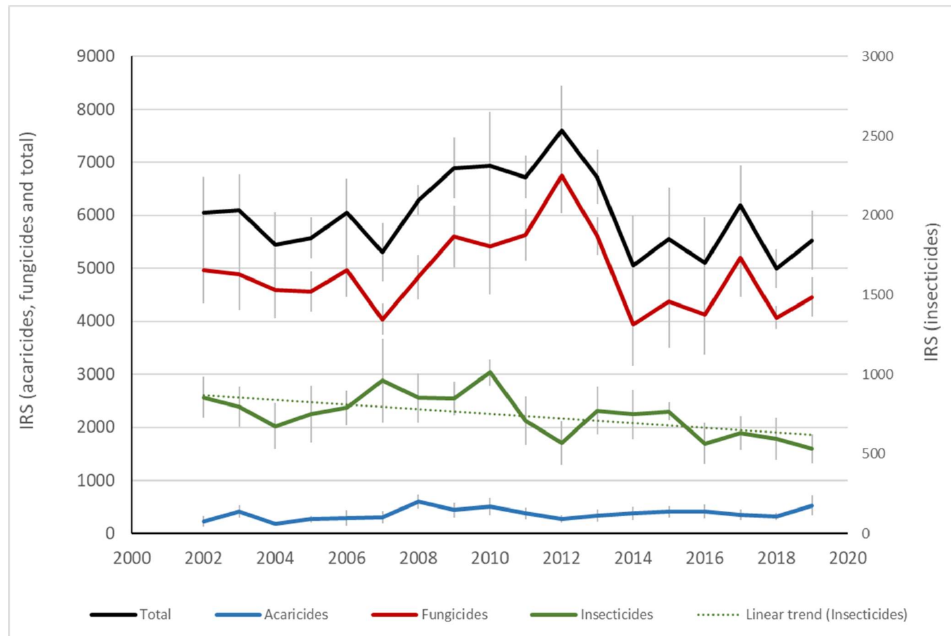
Figure 11. Impact of pesticides as expressed by the Quebec health risk indicator (IRS) and estimated annually from treatments applied in commercial orchards from 2002 to 2019 (phase 2). Orchards located at Compton, Dunham, Franklin, Hemmingford, Oka, Sainte-Famille and Saint-Joseph. Vertical bars represent standard error. Only significant trends ( p < 0.05) are shown.